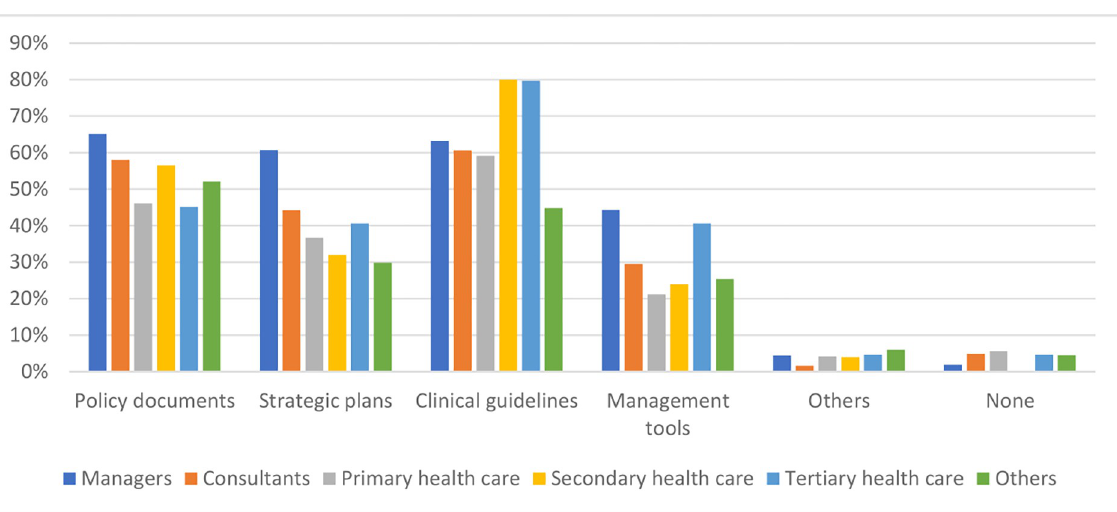
Fig 3. Proportion of TB health professionals who thought that multimorbidity is mentioned in TB policies and guidelines.